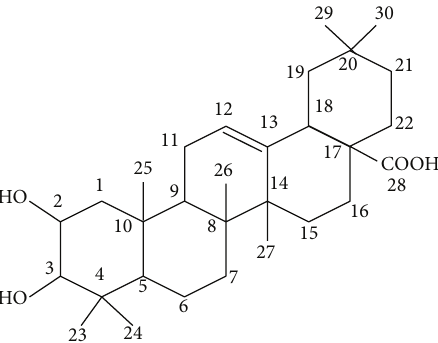
Figure 1: Molecular structure of maslinic